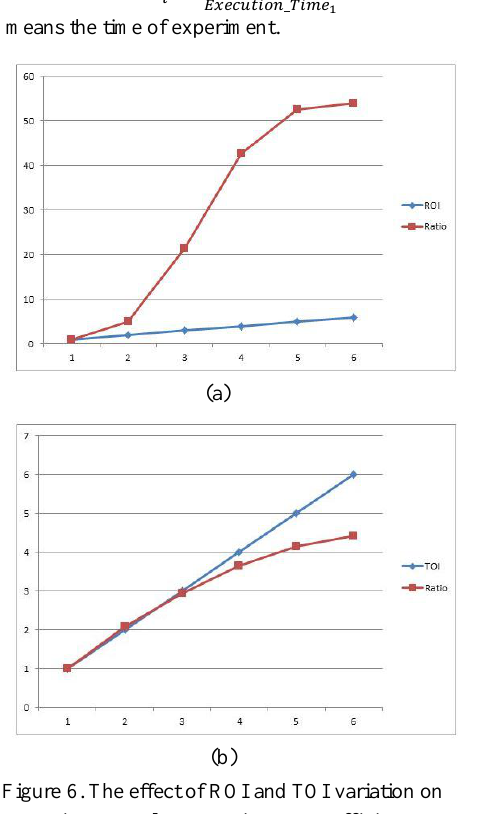
Figure 6. The effect of ROI and TOI variation on spatiotemporal aggregation query efficiency